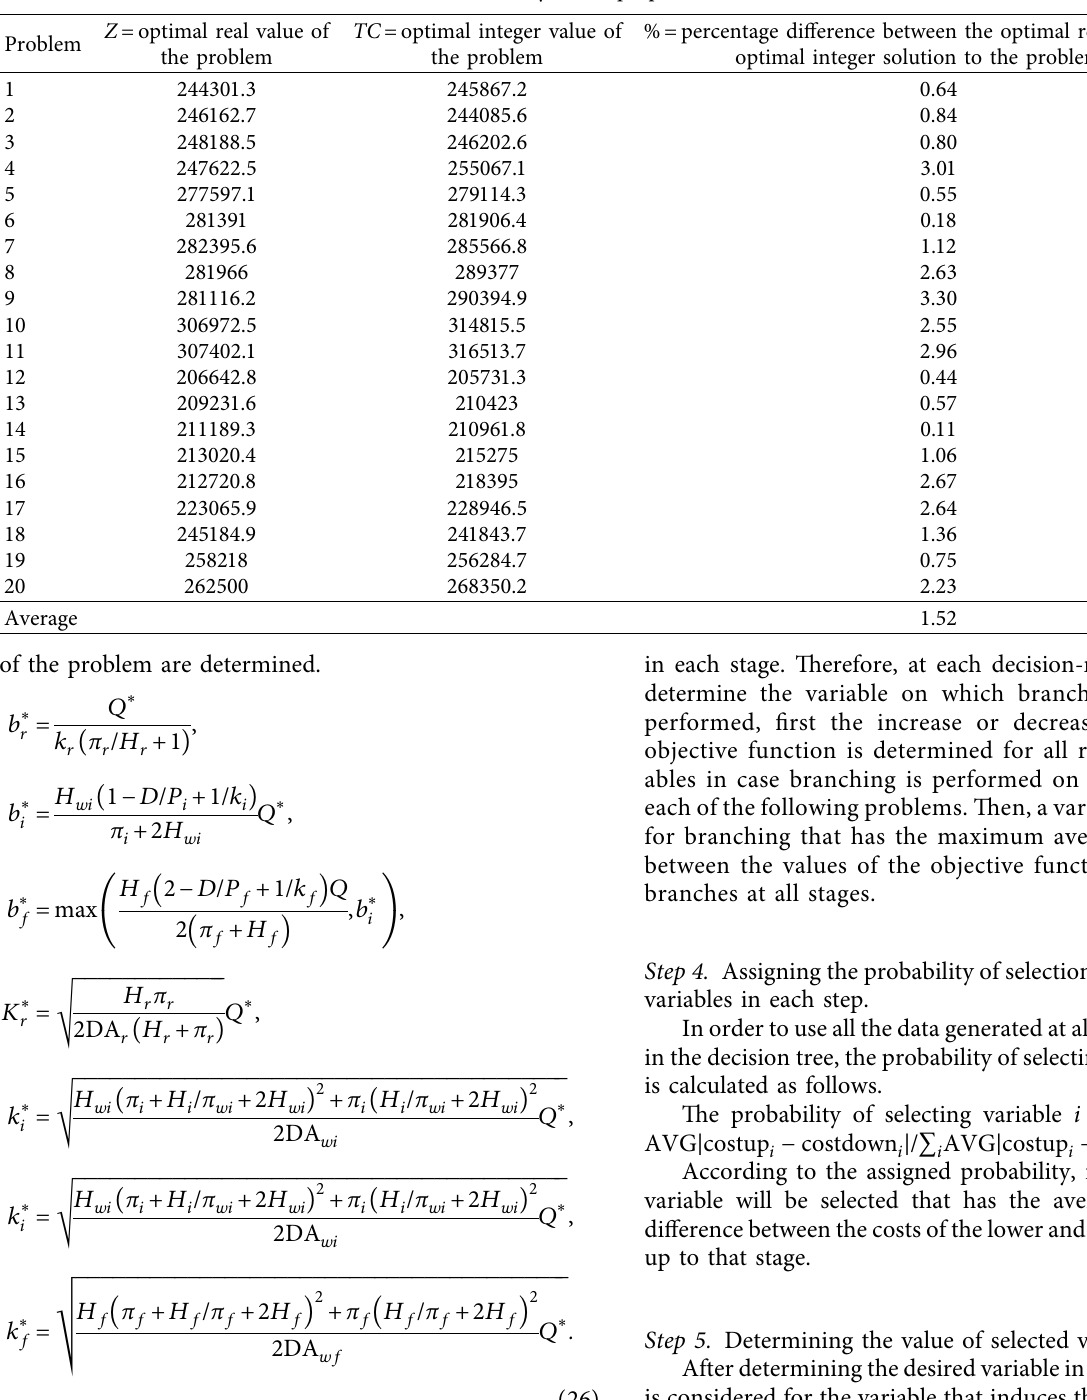
Table 4: Efficiency of the proposed heuristic